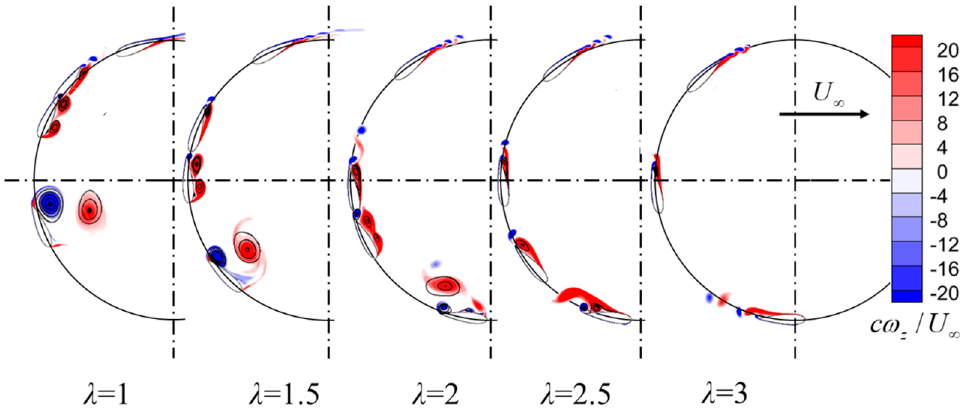
Figure 14. Vorticity contours with different λ for selected azimuth.